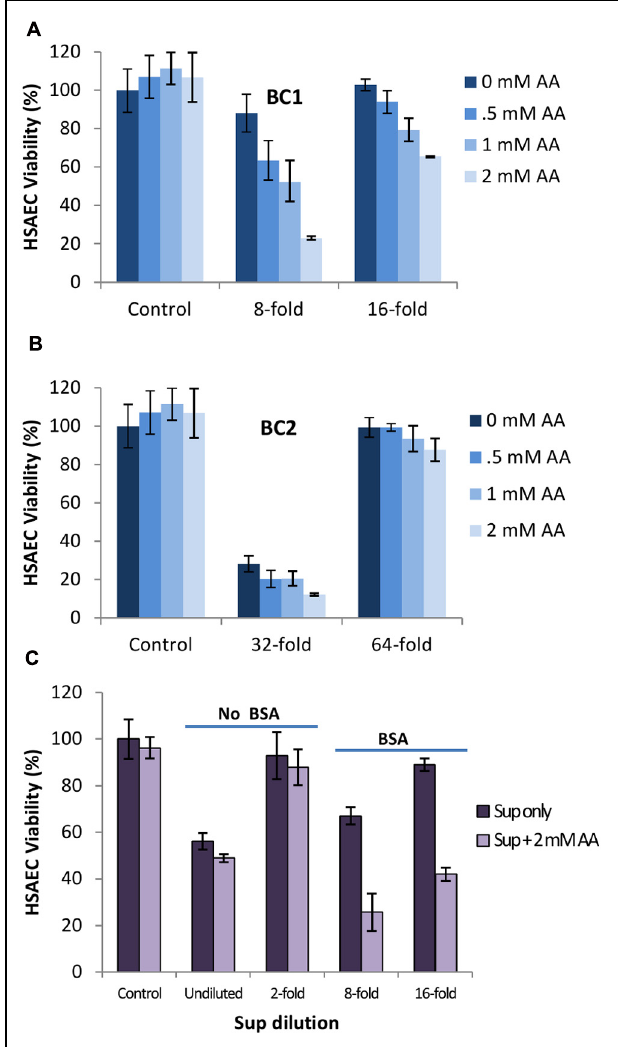
FIGURE 8 | Ascorbic acid (AA) potentiates the toxicity of Sups in BSA-dependent manner. (A,B) Strains BC1 and BC2 were inoculated into DMEM medium with 1 g L − 1 of BSA and grown under microaerobic conditions. Dilutions were made with medium titrated using HCl to the pH of grown cultures. Then, 100 mM stock of ascorbic acid in water was prepared and added to Sups at a concentration of 0, 0.5, 1, and 2 mM and incubated for 2 h at room temperature. The corresponding pH values were 5.42, 5.34, 5.28, and 5.08 in the case of BC1 and 5.35, 5.29, 5.11, and 4.96 in the case of BC2. HSAECs were exposed to the Sups for 20 min and viability was determined. (C) Strain BC1 was grown with and without BSA, and the effect of added AA was assessed as in (A) and (B) . Controls represent viability of mock-treated